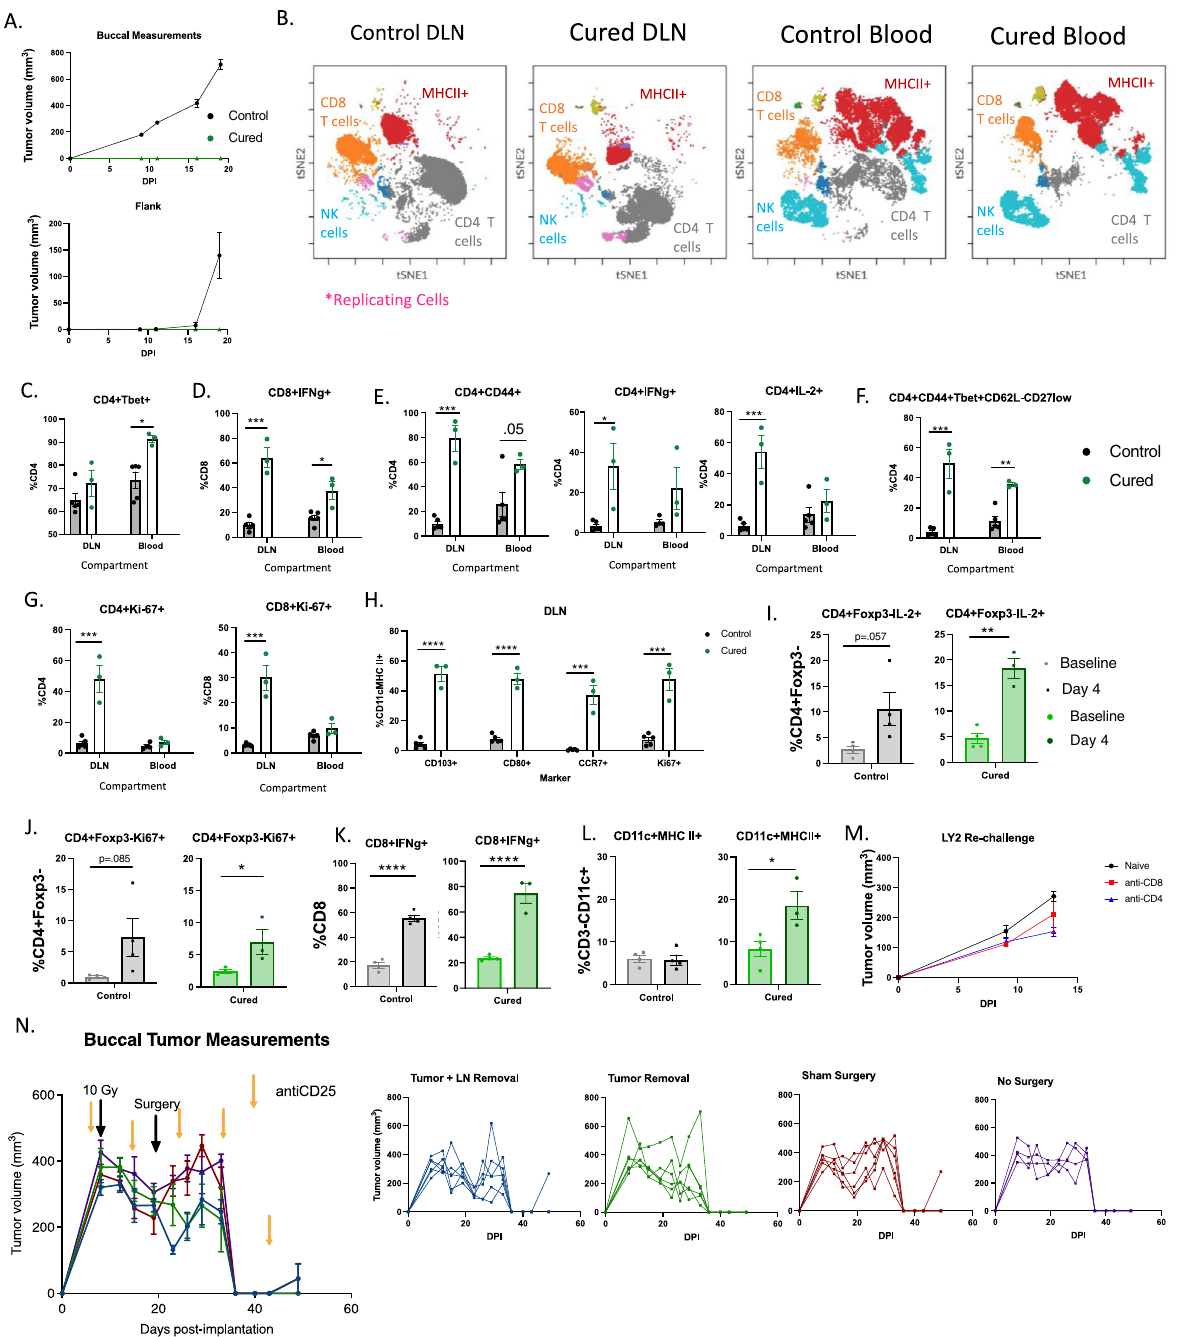
Fig. 3 | Systemic, long-term, DLN-independent memory is formed with tumor only SBRT. A Tumor growth curves of mice rechallenged with LY2 tumor cells